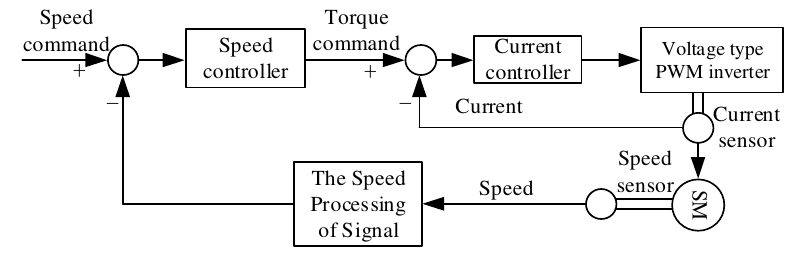
Figure 9. The block diagrams of the control system.